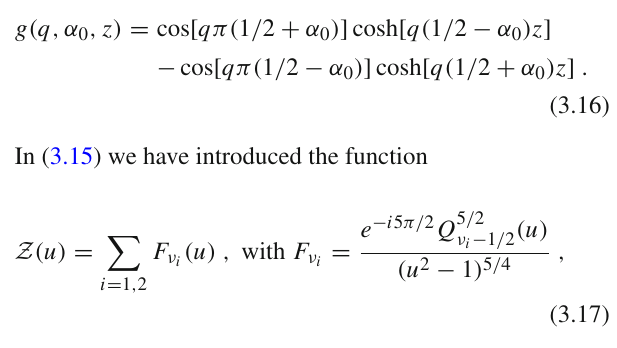
Fig. 2 The VEV of the string contribution to the induced azimuthal current in Eq. (3.15) is plotted, in units of a 5 e − 1 , as a function of r /w for α 0 = 0 . 25, ma = 5, q = 1 . 5 , 2 . 5 and 3 .